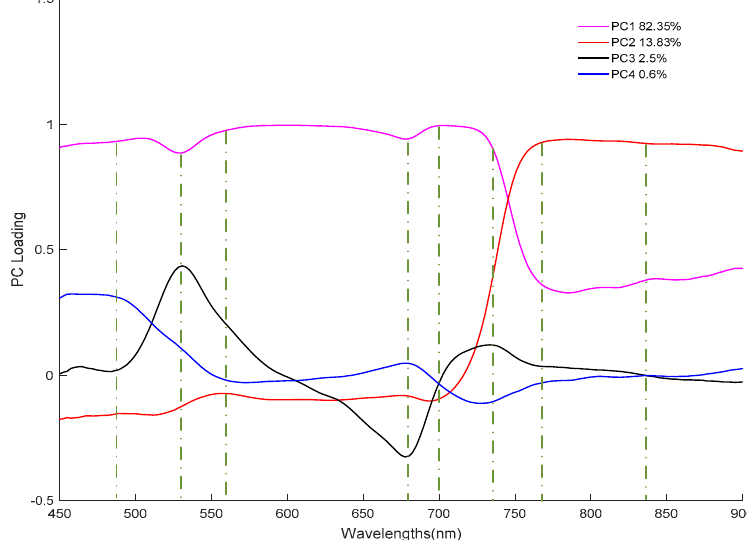
Figure 5. Effective variables selected by principal component analysis (PCA).